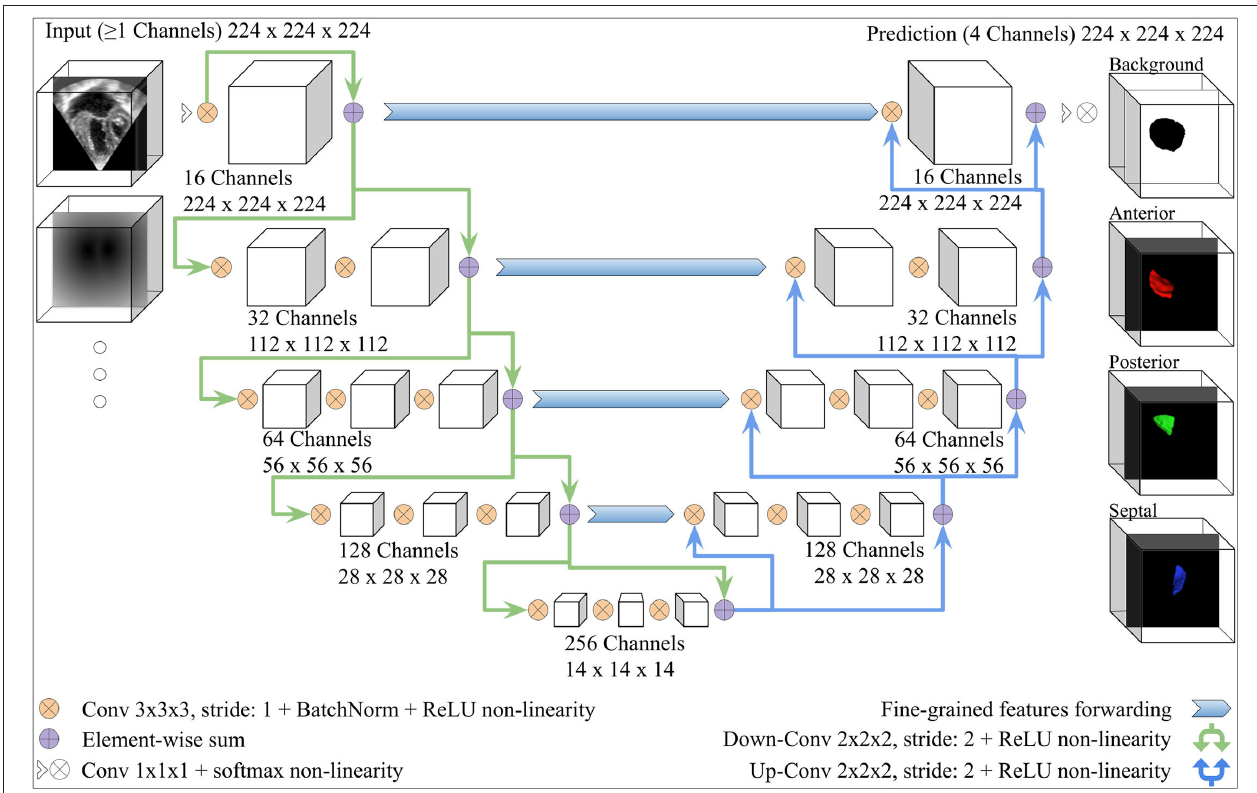
FIGURE 3 | V-Net Model, modified from (34). The model input includes one channel for the MS frame and additional channels with the same dimensions for any other inputs (e.g., the annulus SDM). On the right-hand side, example 3D segmentations predicted by the FCN are displayed from the atrial